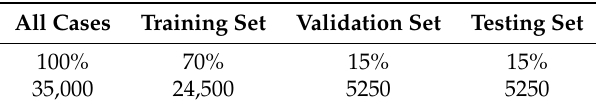
Table 2. Division of data sets into training, test and